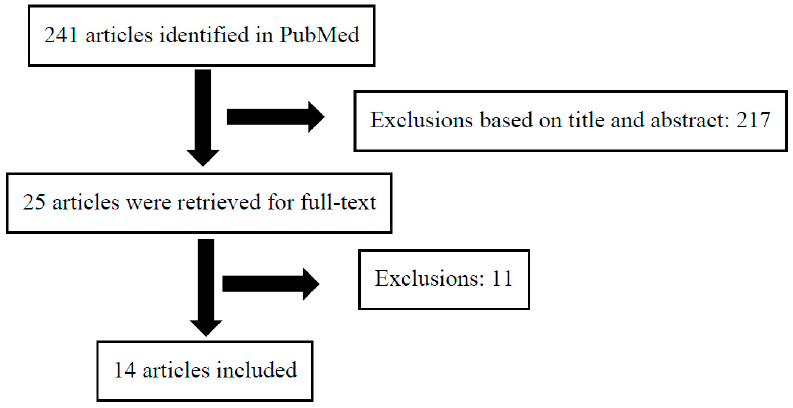
Figure 1. Flow diagram for meta-analysis.